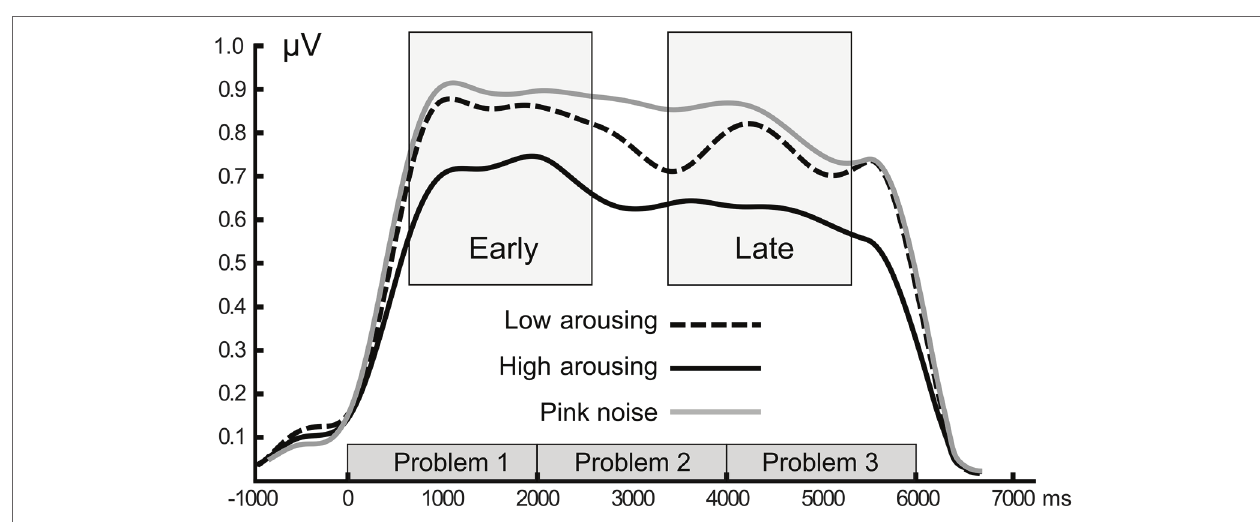
FIGURE 5 | Grand mean time-varying ssVEP amplitude. Time course of the ssVEP amplitude over occipital sensors evoked by the math-problem stream for the three sound distractor conditions. Grand means of 20 participants are depicted. Time windows used for statistical analysis are shown as gray boxes. Amplitude shows enhanced distraction (i.e., lower signal strength) when high-arousing sounds were presented.